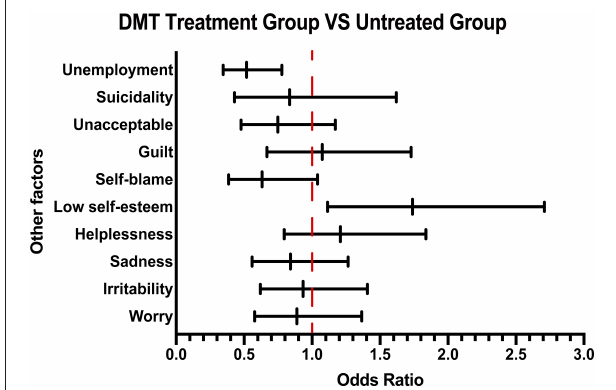
FIGURE 4 | Other emotional and employment factors differing between the DMT-treated group and untreated group. The forest plot shows odds ratio differences in other factors between the DMT treatment group and untreated group.